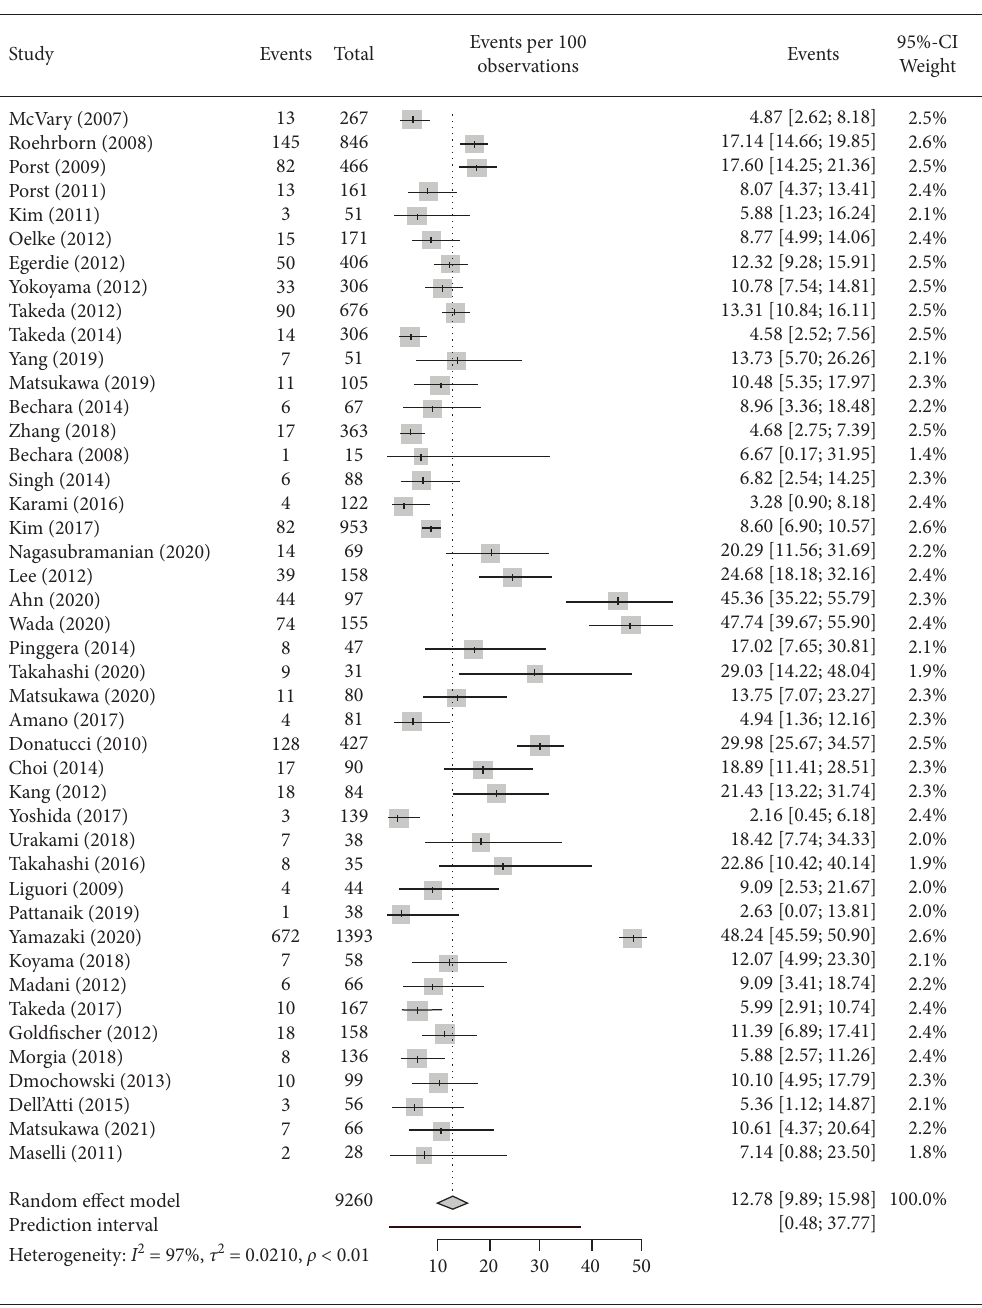
Figure 2: Forest plot illustrating the single study and summary incidence of discontinuation with tadalafl alone or in combination with ABs for LUTS with or without ED. ABs: a-blockers; CI: confdence interval; ED: erectile dysfunction; LUTS: lower urinary tract